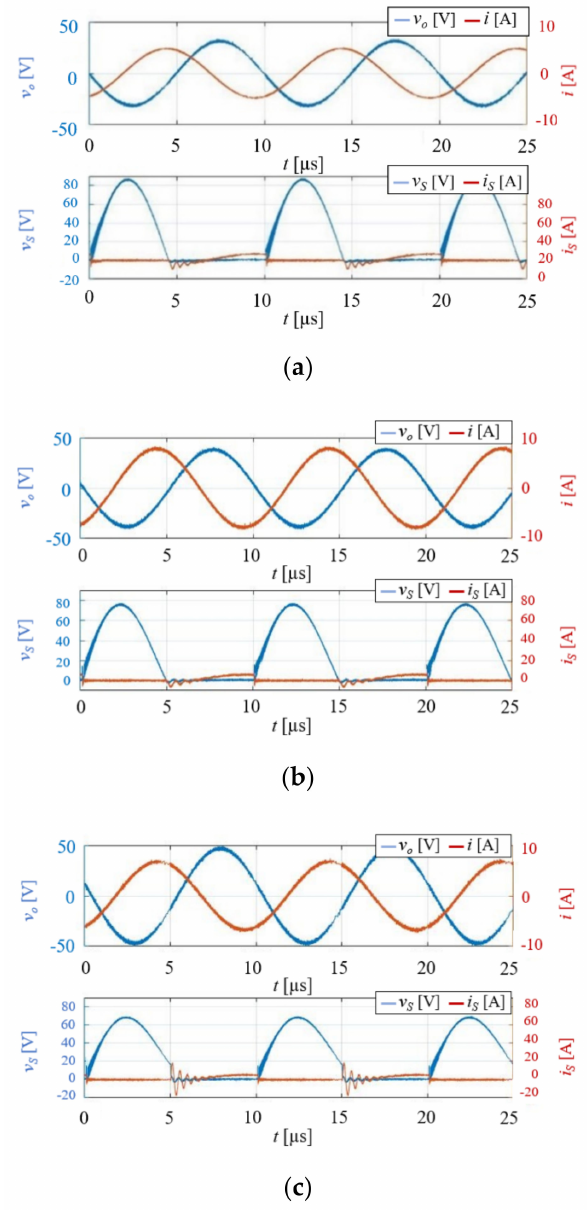
Figure 13. Experimental waveforms versus C M variations. ( a ) 25 pF. ( b ) 32 pF. ( c ) 45